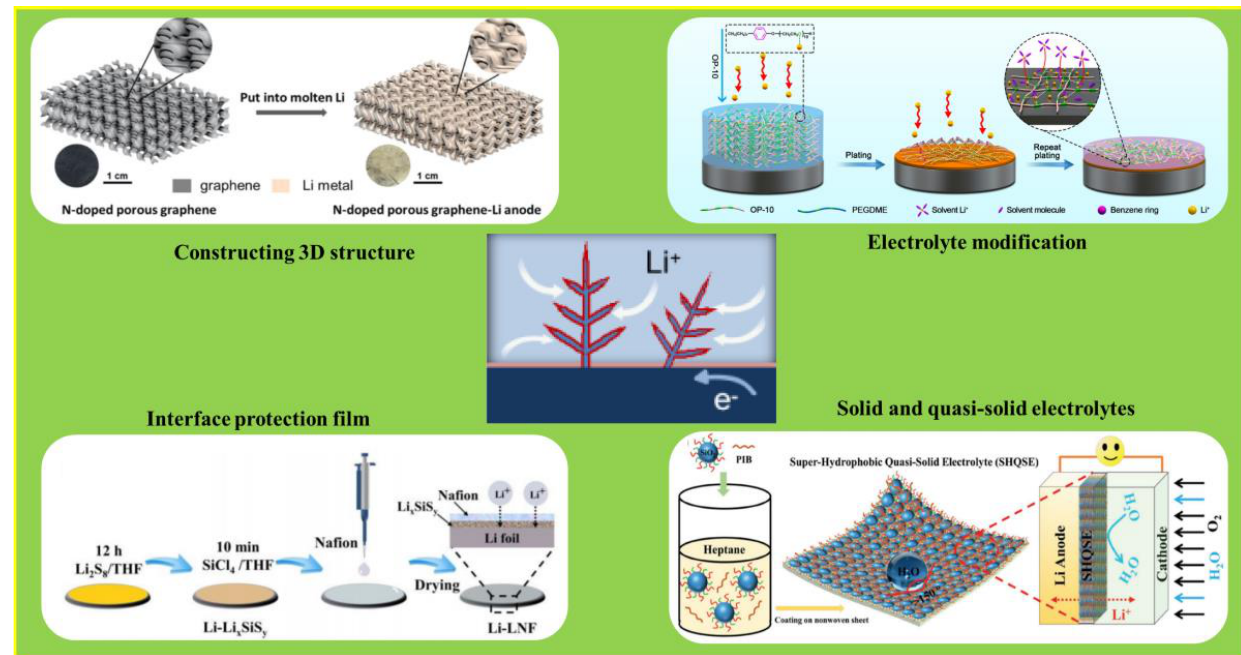
Figure 1. Various strategies to inhibit lithium dendrite growth.